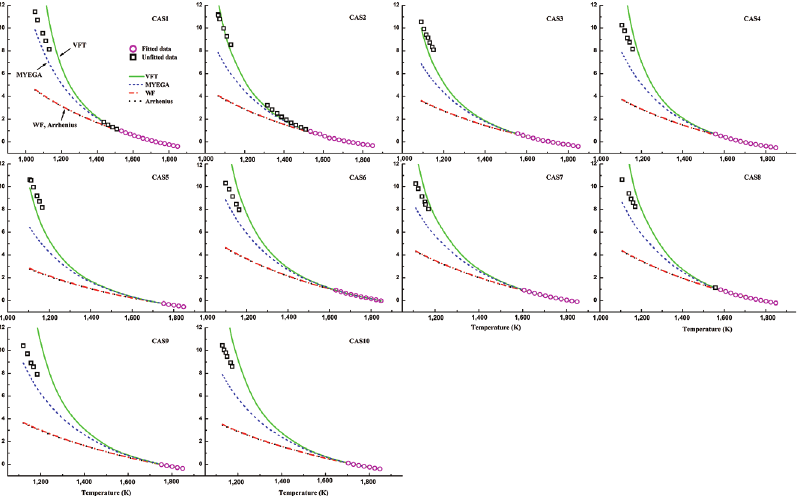
Figure 5: Viscosity extrapolation from high temperature to low temperature for 10 calcium aluminosilicate